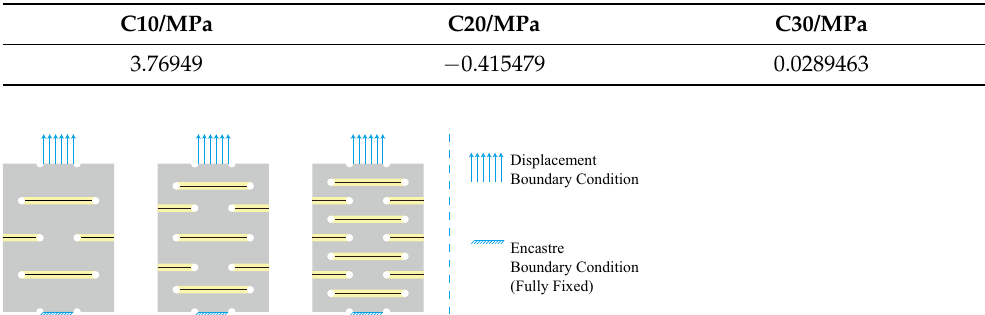
Table 1. Material parameters of PU in [41].